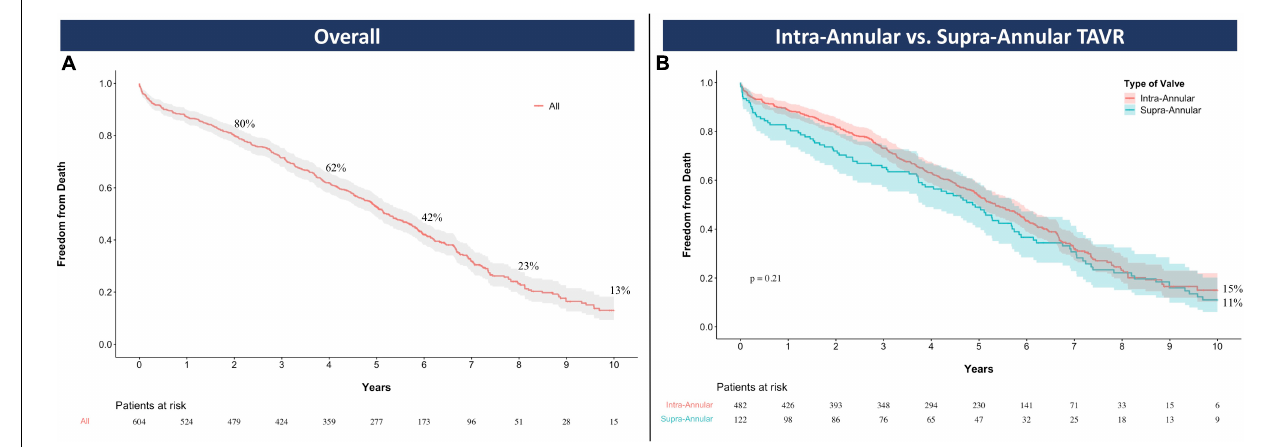
FIGURE 1 | Overall survival with Kaplan Meier estimates for the entire study population (A) and the comparison between intra-annular and supra-annular devices (B) . TAVR, transcatheter aortic valve replacement.